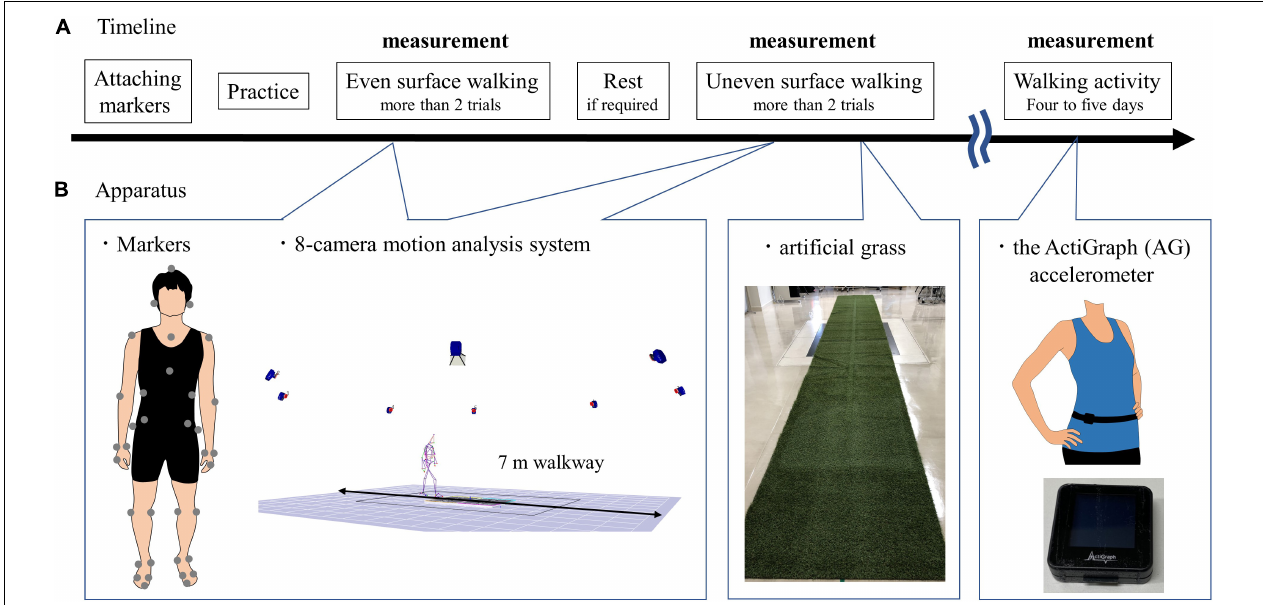
FIGURE 1 | Experimental paradigm. (A) Timeline. Even surface walking was completed first by all the participants; uneven surface walking was second after attaching markers. The participants were allowed to rest between the trials if required. After the gait assessment, the subjects wore the ActiGraph (AG) accelerometer (GT9X Link, ActiGraph LLC, Pensacola, FL, United States) around the waist at the height of the iliac crest on the right side in healthy controls and on the non-PS in poststroke patients; the device was held in place by an elastic belt. The AG accelerometer was worn for at least 4 days and at most 5 days. (B) Apparatus. Forty markers were attached to 13 segments; a 7 m gait on the even surface and uneven surface was measured using an 8-camera motion analysis system (MAC 3D, Motion Analysis Corporation, Santa Rosa, CA, United States). The artificial grass surface is 7 m long and 1 m wide, with an approximately 2 cm leaf length for uneven surfaces. The size of the AG accelerometer is 35 mm × 35 mm × 10 mm, and its weight is 14 g.